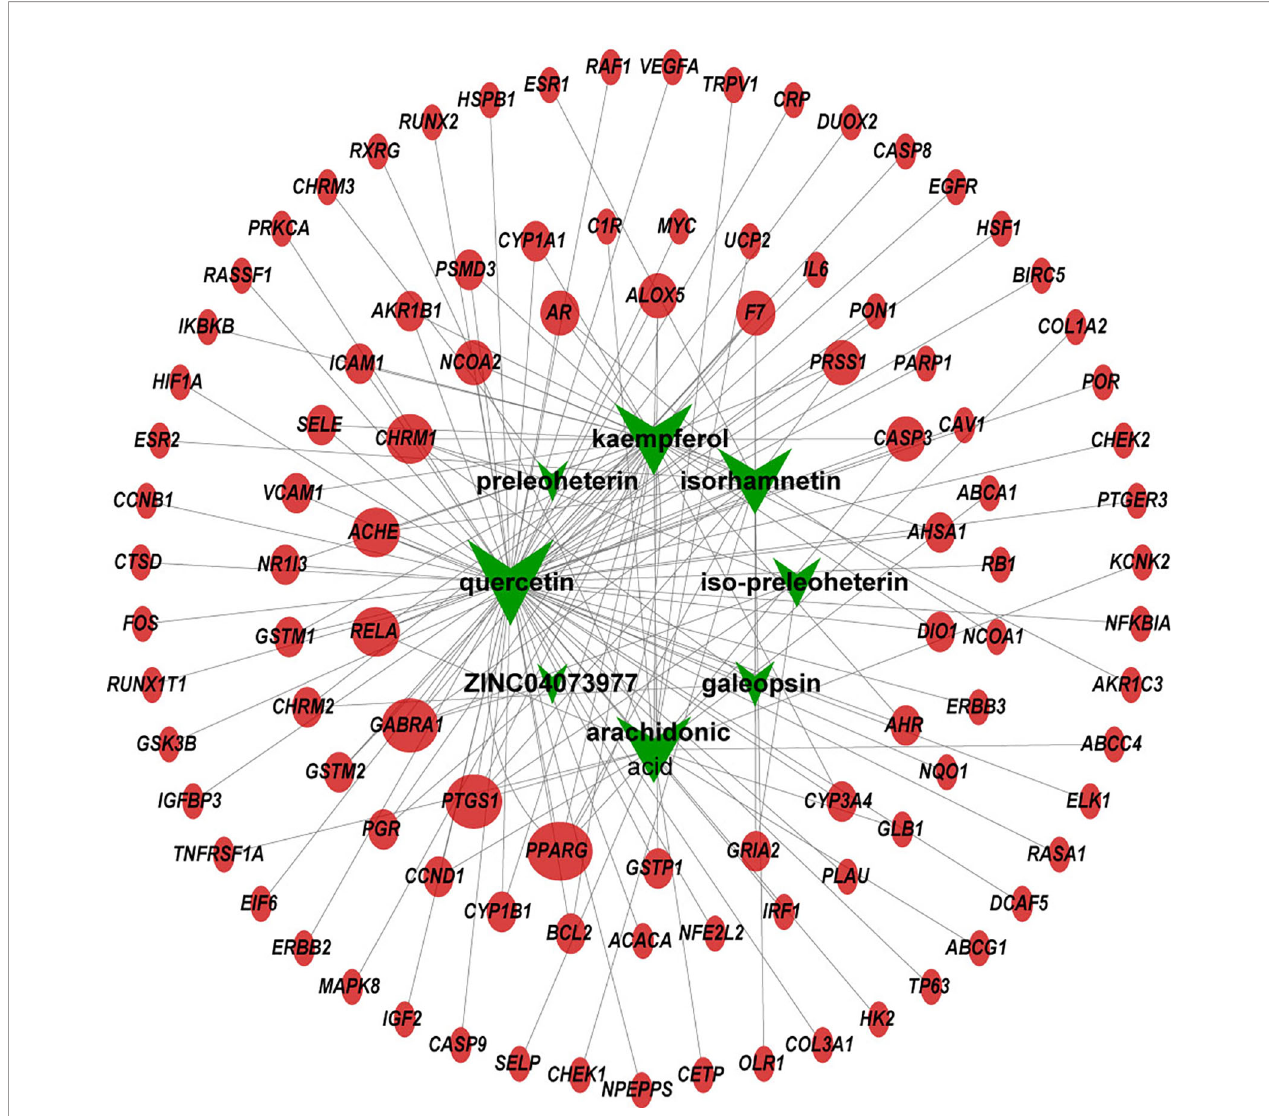
FIGURE 2 | Compound-target network of Yimucao. Green nodes are presented to compounds in Yimucao. Red circle nodes represent for the target genes. The size of the node indicates the size of the